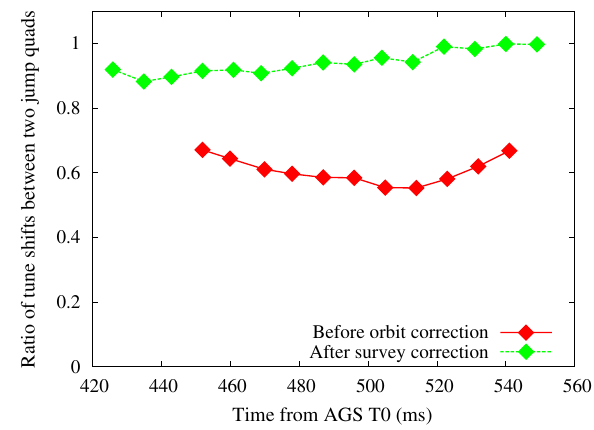
FIG. 3. Ratio of the vertical tune shifts produced by powering each tune jump quad individually at equal current. By design, in a superperiod symmetric AGS, the ratio should be one. AGS acceleration starts at 149 ms from cycle starting time AGS T0. The acceleration ends at 581 ms from AGS